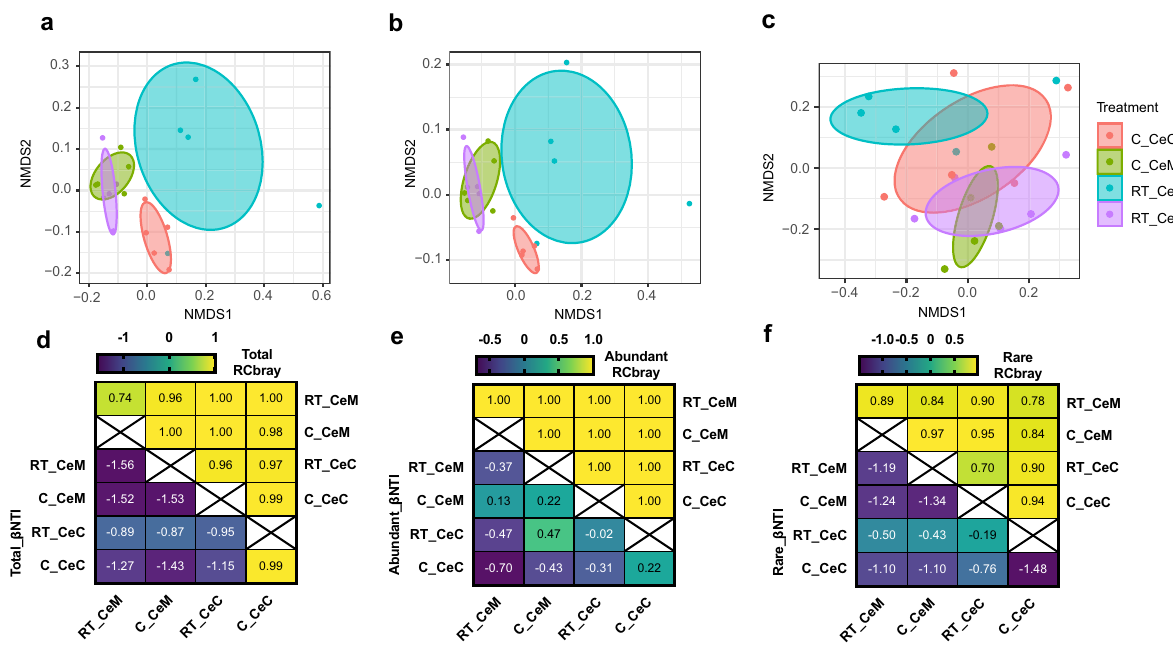
Fig. 7 Taxonomic distribution of total, abundant, and rare ASVs in the different groups. ASVs with average relative abundances ≥ 1% and <0.1% were assigned as abundant ASVs and rare ASVs, respectively. Nonmetric multidimensional scaling (NMDS) plots of beta-diversity were generated from a total ASVs. b Abundant ASVs. c Rare ASVs. Heatmap of beta nearest taxon index ( β NTI) and the Raup – Crick metric based on the relative abundances of the ASVs (RC Bray ) of total, abundant, and rare communities are shown in ( d – f) , respectively. RT_CeM and C_CeM represent the cecal epithelial surface in the RT group and cold-stressed groups, respectively, while RT_CeC and C_CeC represent the cecal content in the RT and cold-stressed groups, communities. Conversely, the RC Bray values of the microbial communities of the rare ASVs were only found to be >0.95 in C_CeM and C_CeM-RT_CeC, and in the other pairwise samples, the RC Bray values were <0.95, re fl ecting that drifting alone (weak selection) determined the composition of the microbial community.